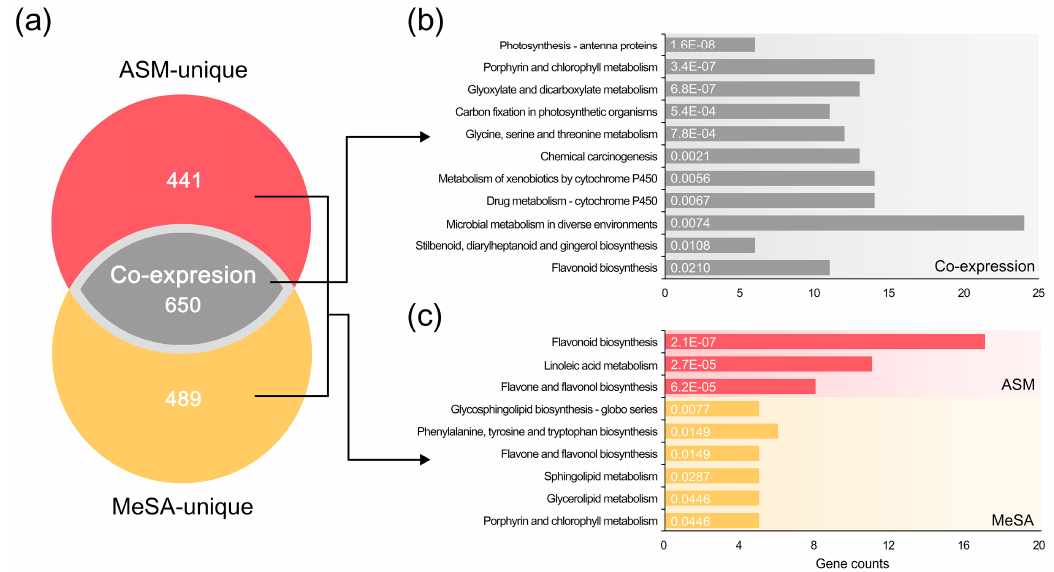
Figure 3. Comparative in vivo transcriptomes of upregulated differentially expressed genes (DEGs) and Kyoto Encyclopedia of Genes and Genomes (KEGG) pathway enrichment in acibenzolar- S -methyl (ASM) and methyl salicylic acid (MeSA) treatment groups. ( a ) A Venn diagram showing the co-expression and unique expression groups of upregulated DEGs. Comparative analysis revealed 650 overlapping DEGs. A further 441 and 489 DEGs were identified as being uniquely expressed in response to the ASM and MeSA treatments, respectively. ( b ) Significantly enriched KEGG pathways for the co-expression group. Significant pathways were identified and ranked based on hypergeometric distribution with an FDR < 0.05. The length of bars indicates the number of DEGs in each KEGG pathway. ( c ) Significantly enriched KEGG pathways for ASM- and MeSA-specific patterns.